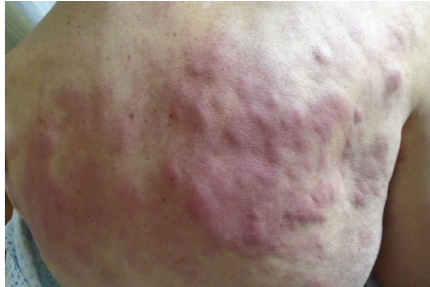
Figure 2: Picture of the patient taken on the day of admission show- ing again the diffuse elevated blanching red-violaceous confluent lesions over the back.